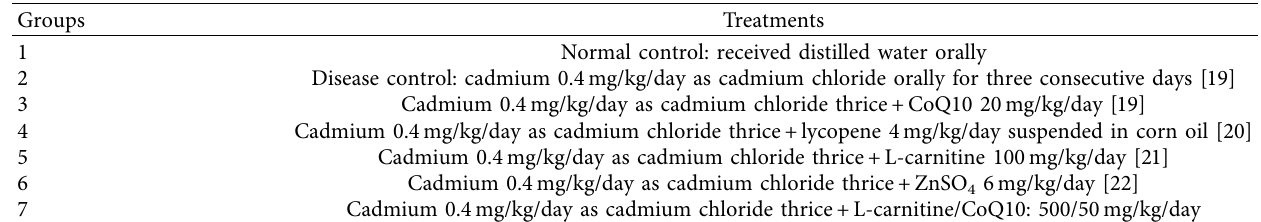
Table 1: Treatment plan for study of cadmium-induced infertility in male rats. Groups Treatments 1 Normal control: received distilled water